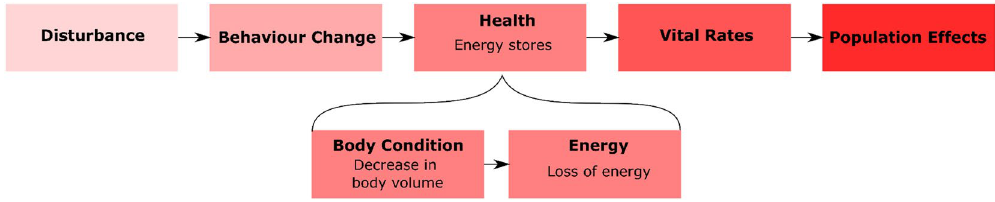
Figure 4. Modified overview of the Population Consequences of Disturbances (PCoD) framework with insert showing where UAS-photogrammetry can be used to quantify changes in body volume and make inferences about energy loss and animal health. Figure has been modified from 4